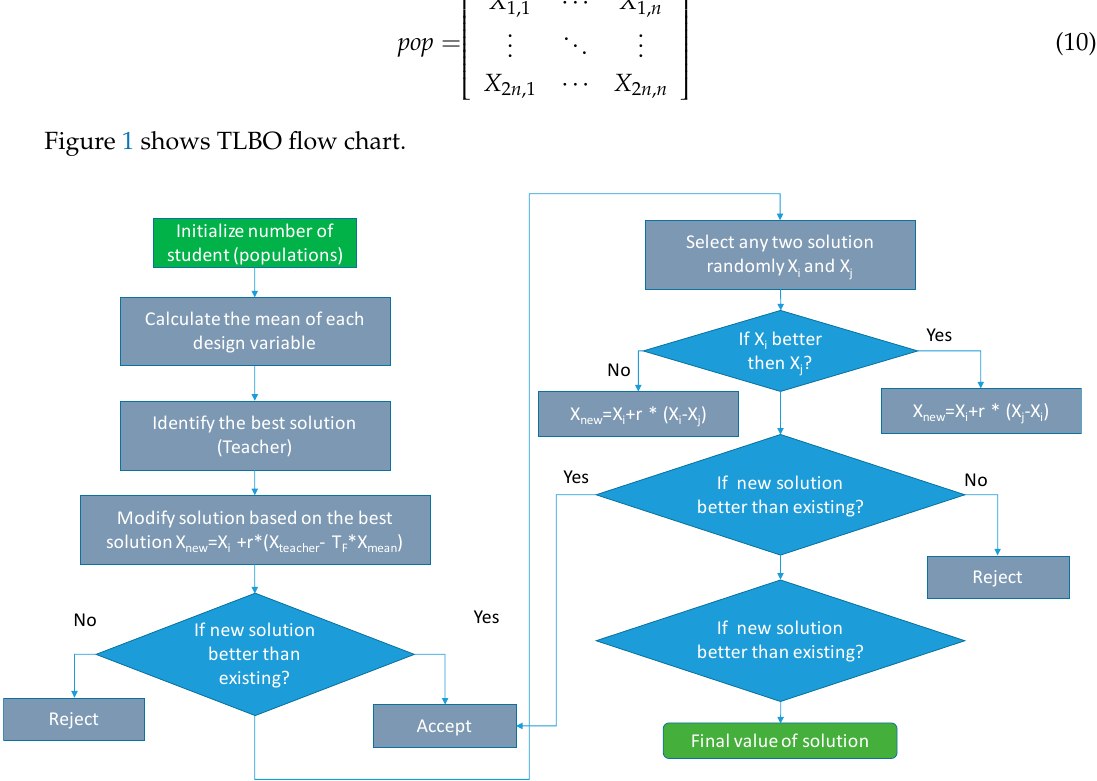
Figure 1. Flow chart of the teaching learning based optimization (TLBO) Algorithm.